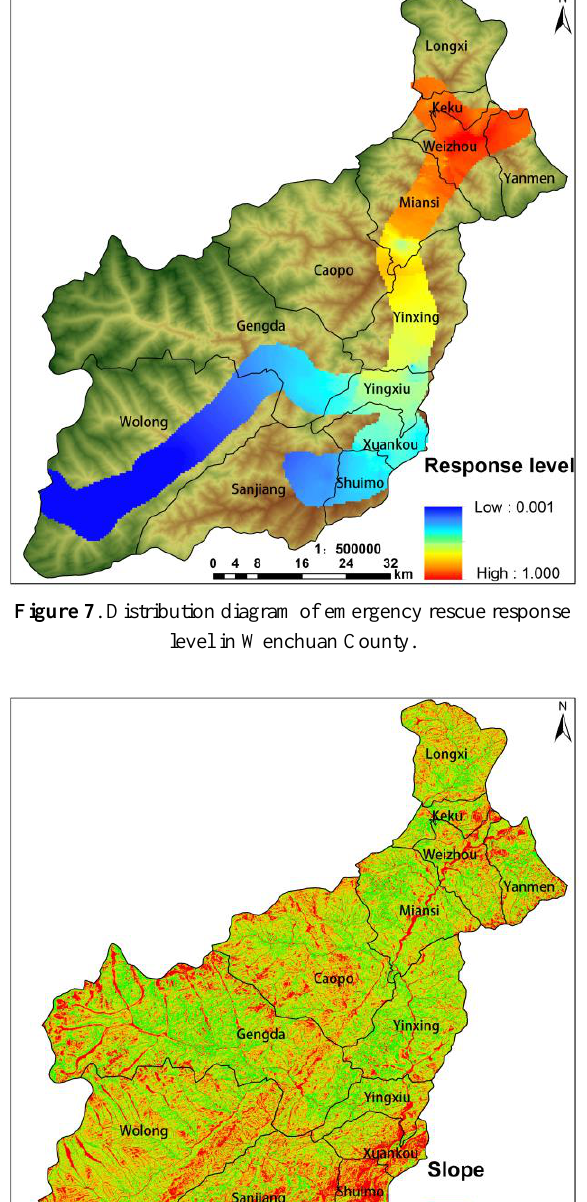
Figure 8 . Slope in Wenchuan